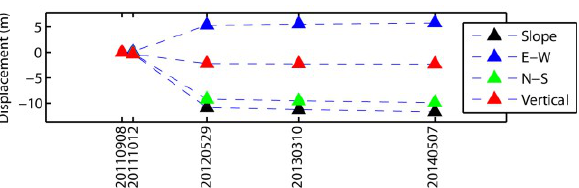
Figure 4: (a) GPS driven Displacement time series of point 6 (M6 in Figure 3(b)) in slope, East-West, North-South and Vertical